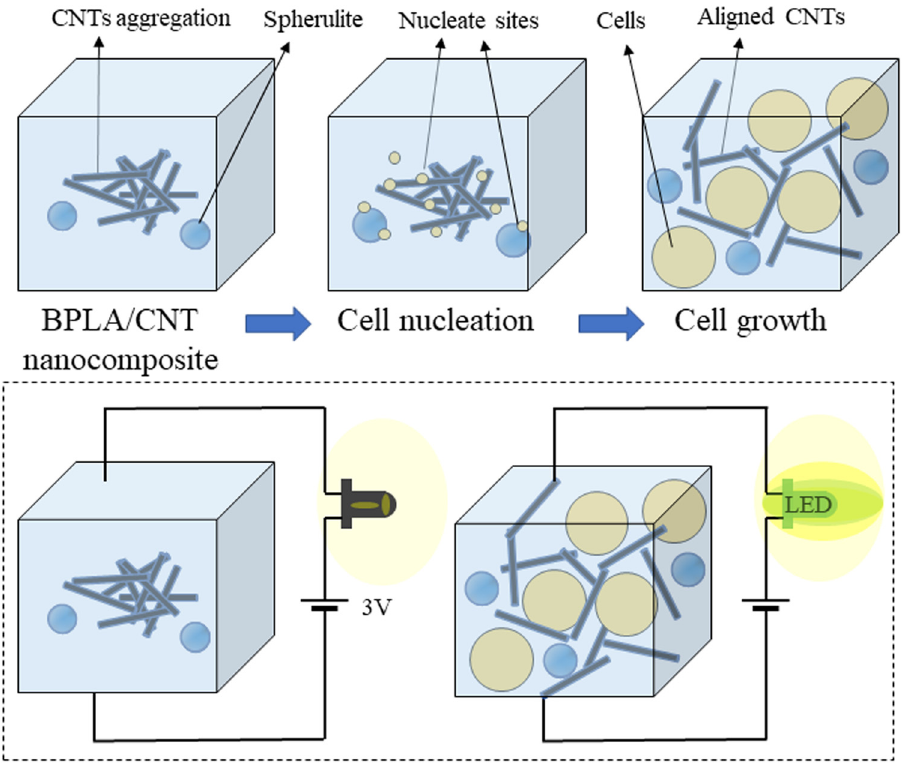
Figure 9: Schematic illustration for the dispersion morphologies of BPLA/CNT